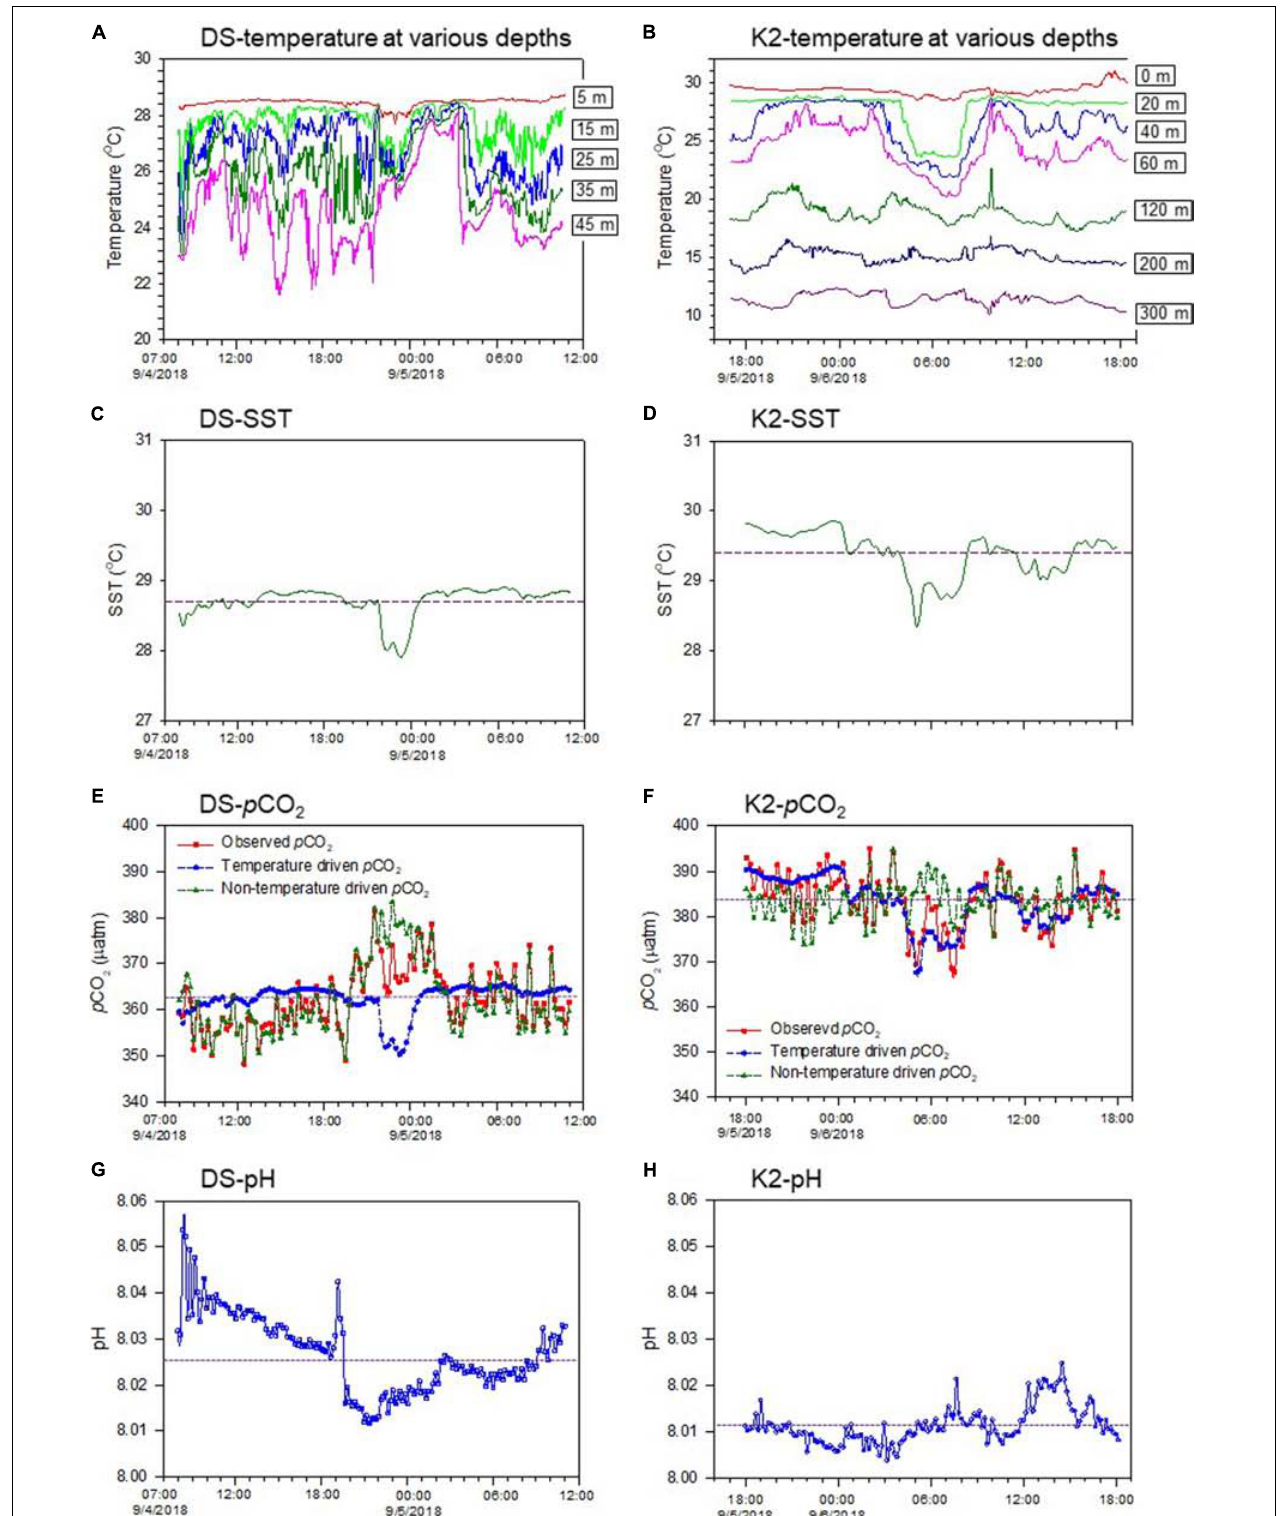
FIGURE 2 | Moored buoy data showing the high-frequency variations in temperature at various depths (A,B) , surface temperatures ( C,D ; recorded by Mini CO2TM sensor), the observed, temperature driven, and non-temperature driven p CO 2 levels (E,F) (see text for details) and pH values (G,H) at a water depth of 2 m at the DS and K2 stations. Dashed lines represent average